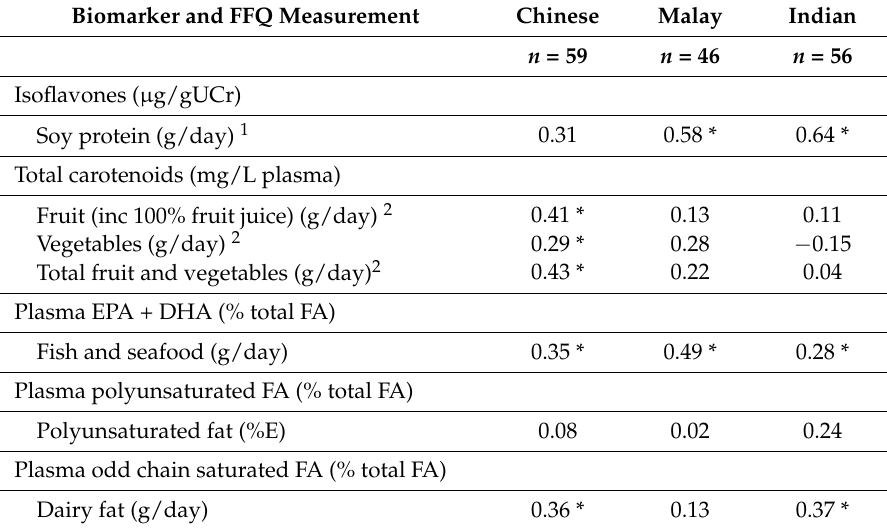
Table 5. Pearson correlations between FFQ2 and biomarkers, by ethnic group, n = 161. Biomarker and FFQ Measurement